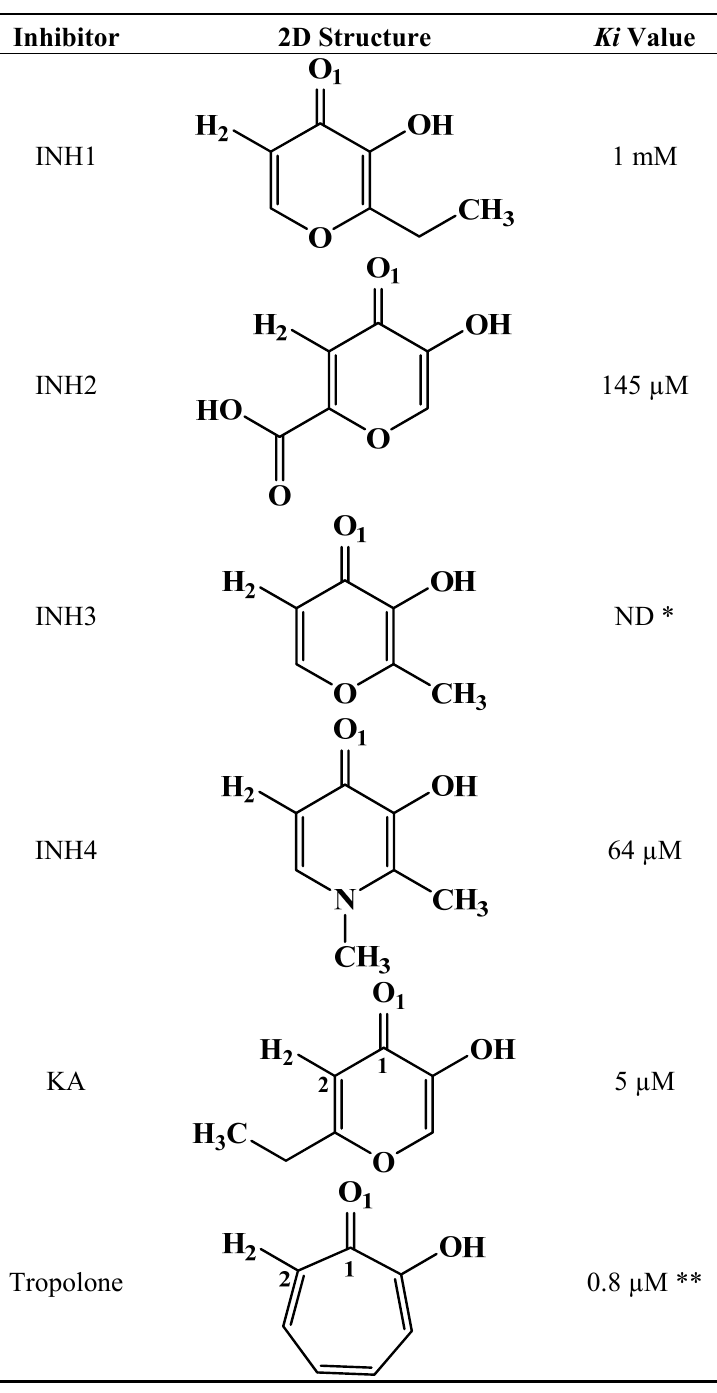
Table 1. General informations about Ab TYR inhibitors analyzed in this